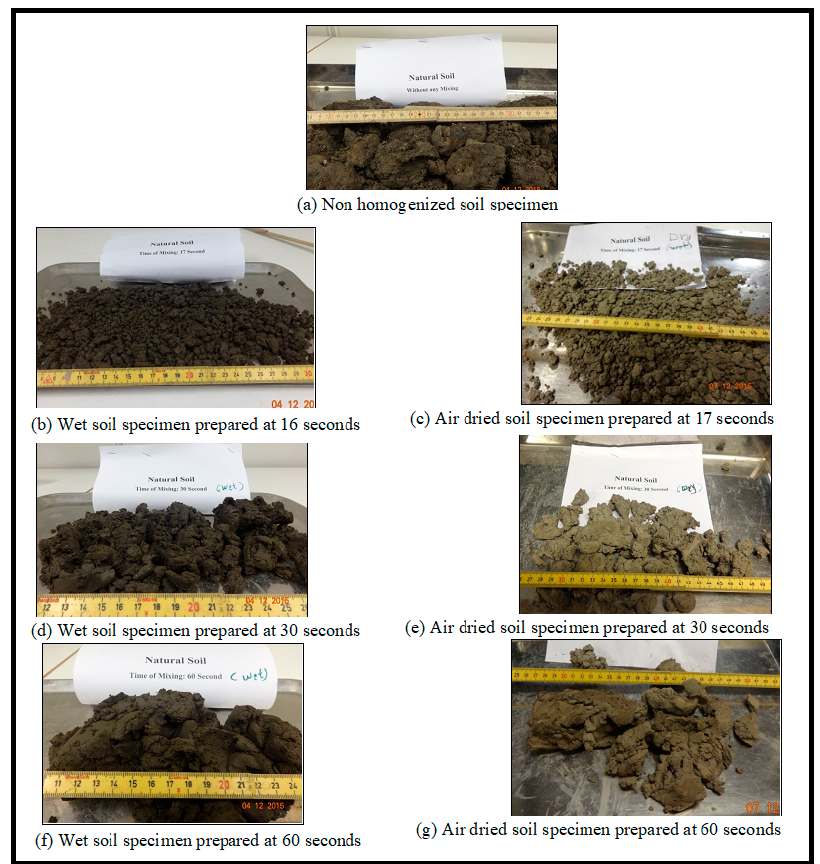
Figure 3. Visual evaluation of Soil 1 before and after disintegration at various times: ( a ) Non homogenized soil specimen; ( b ) Wet soil specimen prepared at 16 seconds; ( c ) Air dried soil